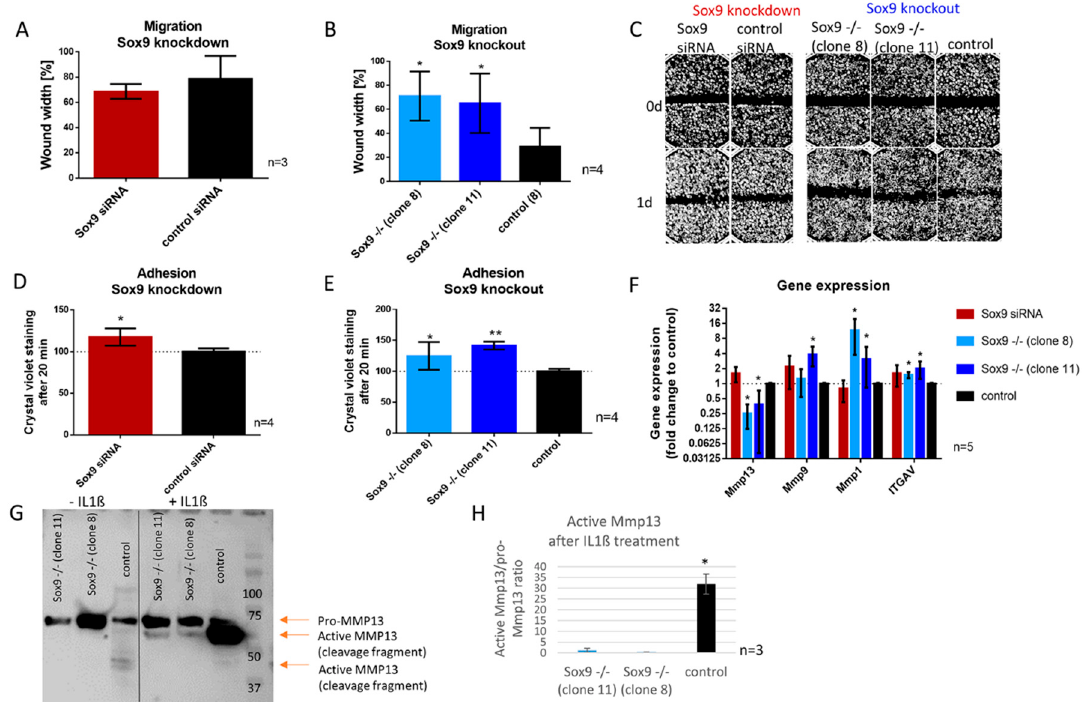
Figure 4. Effect of SOX9 knockdown and knockout on migration and adhesion. ( A , B ) Migration (wound healing) assay of SOX9 knockdown and knockout cells showed decreased migration (wider wound) in SOX9 knockout clones 8 and 11 compared to the control. ( C ) Representative pictures of wound healing assays after SOX9 knockdown and knockout (Magnification 4×). ( D , E ) Adhesion to cell culture plastic surface increased significantly after SOX9 knockdown and knockout. ( F ) Gene expression analysis showed a decreased expression of MMP13 and an increased expression of MMP9 and MMP1 and ITGAV after SOX9 knockout. ( G ) Western blot analysis of MMP13 revealed a hampered ability to activate MMP13 in SOX9 knockout clones after IL-1 β stimulation. ( H ) Densitometric analysis of 3 independent Western blots is shown. Results are the means ± SD; * p ≤ 0.05, ** p ≤ 0.01.